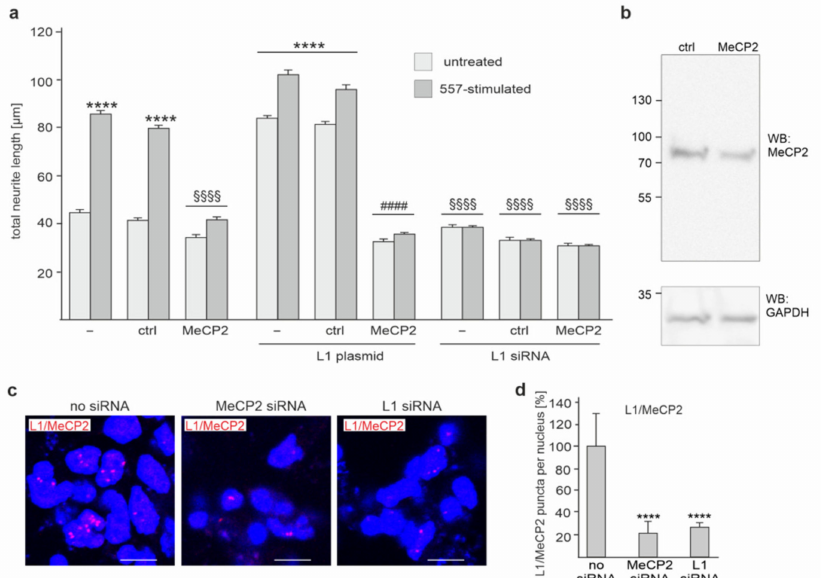
Figure 5. MeCP2 contributes to L1-dependent neurite outgrowth from cortical neurons. ( a , b ) Cortical neurons were transfected without ( − ) or with control siRNA (ctrl) or MeCP2 siRNA (MeCP2) alone, with L1-encoding plasmid (L1 plasmid) or L1 siRNA alone or together with control siRNA or MeCP2 siRNA. Neurons were then treated without or with L1 antibody 557. ( a ) Mean values + SEM from three independent experiments are shown for total neurite lengths (**** p < 0.001 relative to mock-transfected neurons, #### p < 0.001 relative to neurons transfected with L1 plasmid alone, §§§§ p < 0.001 relative to mock-transfected neurons treated with antibody 557; one-way ANOVA with Dunn’s multiple comparison test). ( b ) Western blot of lysates from cells transfected with control siRNA (ctrl) or MeCP2 siRNA (MeCP2). ( c , d ) Cortical neurons were transfected without (no siRNA) or with MeCP2 siRNA or L1 siRNA and then subjected to proximity ligation with L1 and MeCP2 antibodies. ( c ) Representative images of cells with L1/MeCP2-positive puncta (red) are shown ( n = 3). Nuclei are stained in blue. Scale bars: 5 µ m. ( d ) Mean values + SD from three experiments analyzing 200–500 cells per condition and experiment are shown for the average numbers of L1/MeCP2-positive red puncta per cell relative to the control (values after mock-transfection set to 100%) (**** p < 0.001; one-way ANOVA with Dunn’s multiple comparison